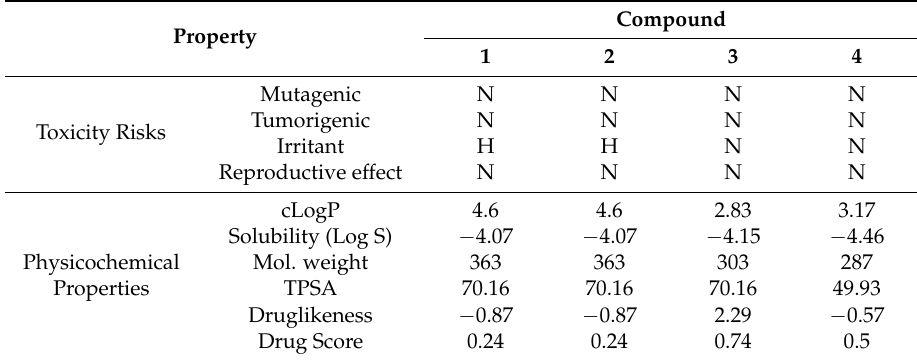
Table 2. OSIRIS toxicological and physicochemical predicted